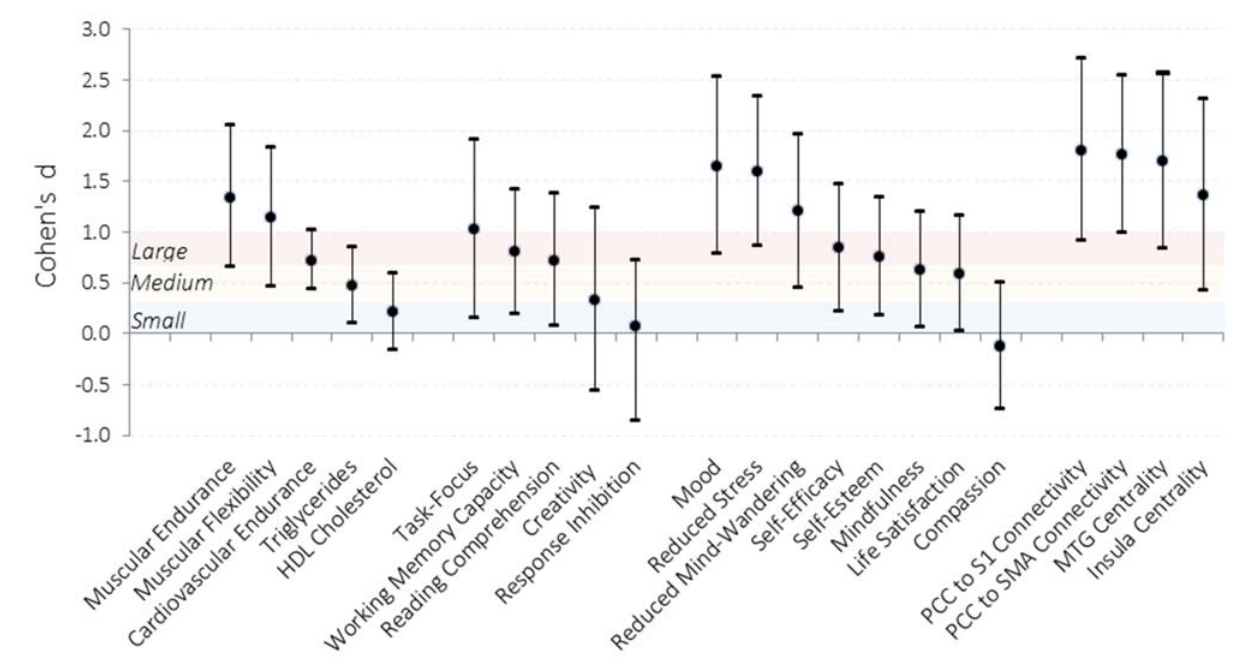
FIGURE 2 | Effect sizes of improvements observed in the intervention condition compared to the waitlist control condition. Effect sizes for each dependent measure were calculated by computing the difference in change from pre-testing to post-testing for the intervention relative to the waitlist control and dividing by the pooled standard error across testing sessions. Error bars represent 95% confidence intervals. Shaded sections demarcate traditional effect size descriptions. PCC, posterior cingulate cortex; S1, somatosensory cortex; SMA, supplemental motor area; MTG, middle temporal gyrus. N = 31.